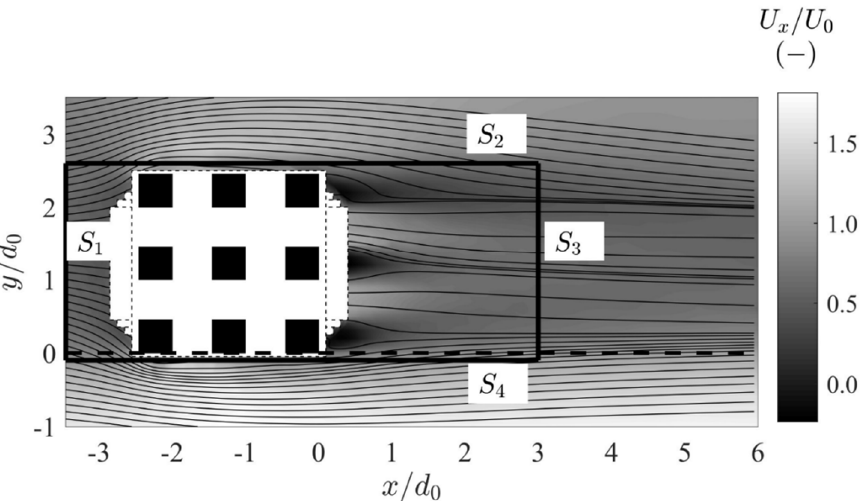
Figure 4. Distribution of time-averaged streamwise velocities and streamlines at z = z 0 for SA_04. Black lines represent the vertical surfaces of the control volume.